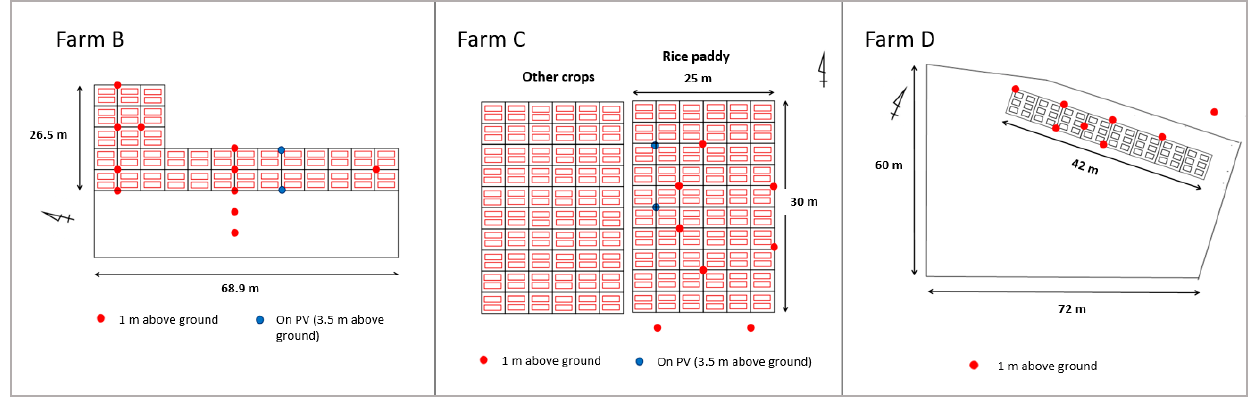
Figure 3. Block diagrams and positions of sensors at Farms B ( left ), C ( middle ), and D ( right ).